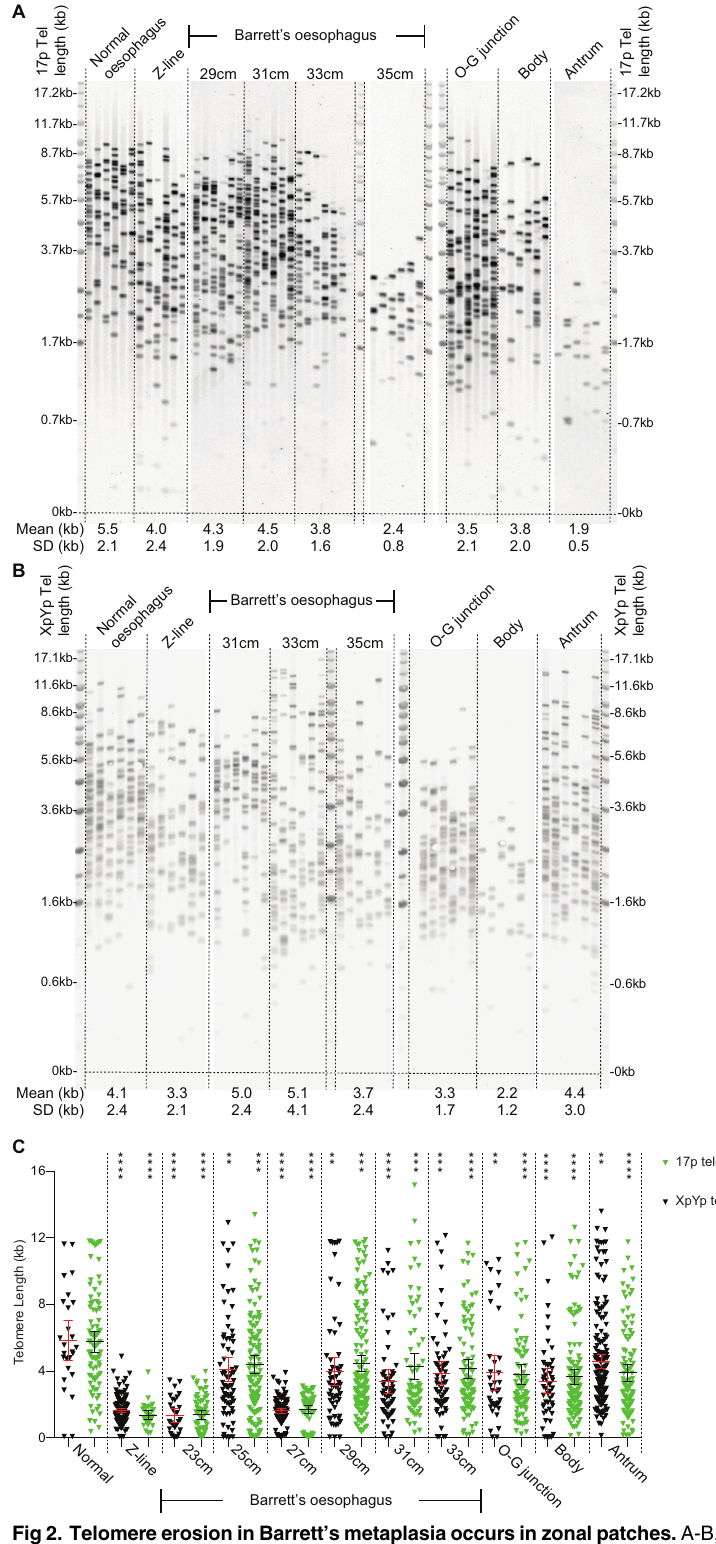
Fig 2. Telomere erosion in Barrett’s metaplasia occurs in zonal patches. A-B, examplesof STELA of multipletissues as indicatedabove from separate two patients. Mean and standard deviationare